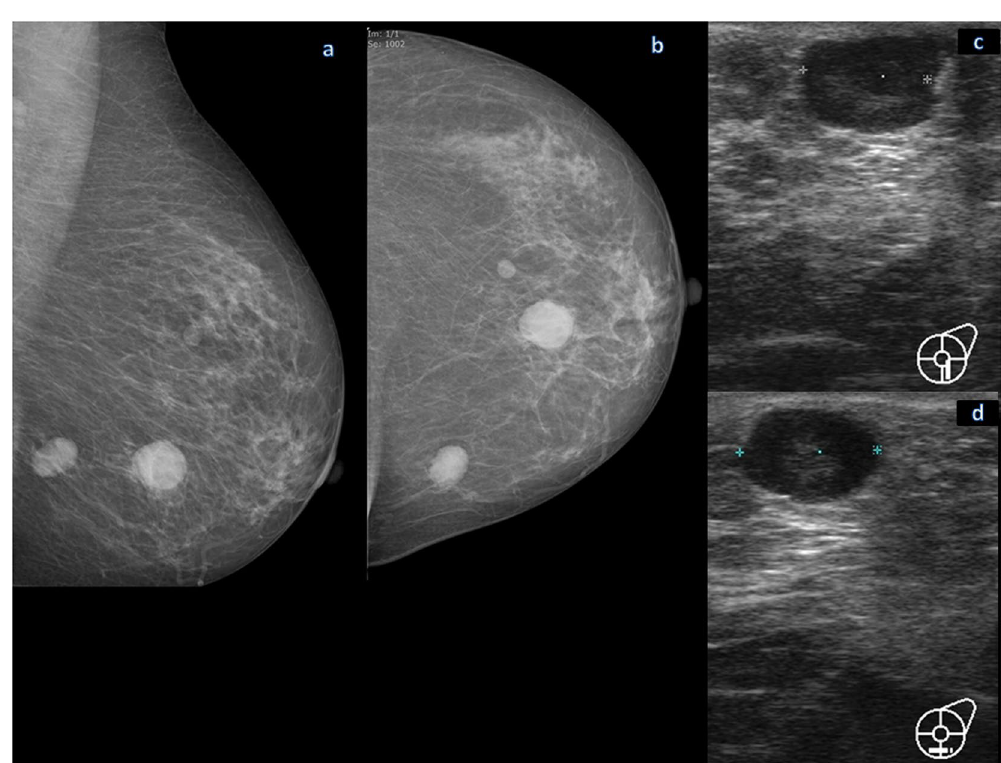
Figure 3. Mammographic and ultrasound findings of a leukemic relapse (acute lymphatic leukemia) affecting the left breast in a 34-year old woman. Mediolateral oblique ( a ) and craniocaudal ( b ) mammogram of the left breast shows three oval or round high-density masses with circumscribed margins. No associated skin thickening or ipsilateral axillary lymphadenopathy is present. The ultrasound findings in vertical ( c ) and horizontal ( d ) imaging planes demonstrated a circumscribed, oval mass with a complex cystic and solid echo pattern with posterior acoustic enhancement, located in the 6 o’clock position of the left